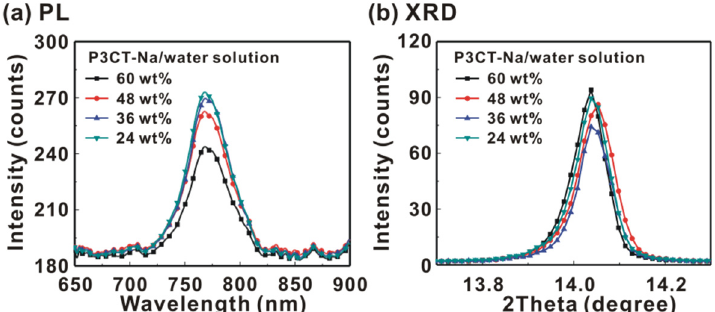
Figure 6. The excitonic and crystal structures of the MAPbI 3 /P3CT-Na/ITO/glass samples: ( a ) pho- toluminescence spectra; ( b ) main X-ray diffraction patterns.